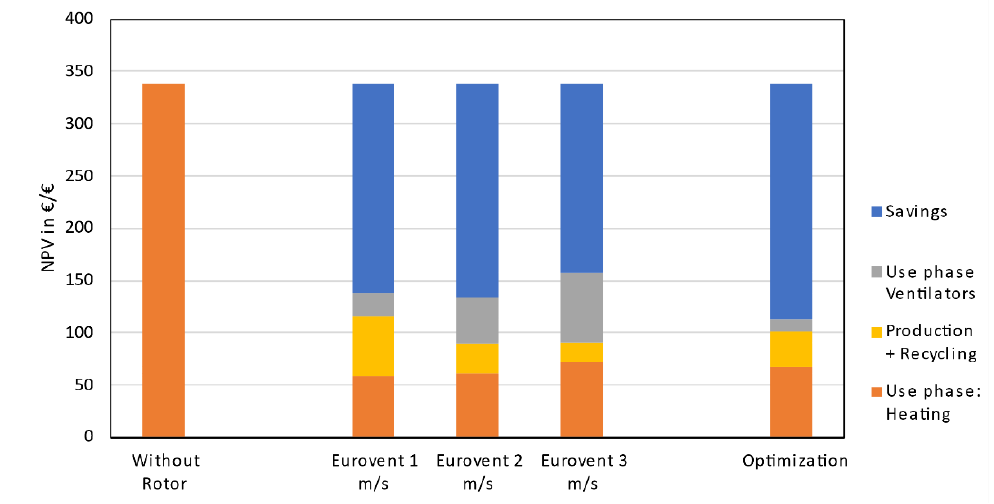
Figure A4. 65 €/t CO 2 Eq. scenario with optimized RHX and Eurovent RHX under different operating ambient air empty tube velocities at 100,000 m 3 /h.